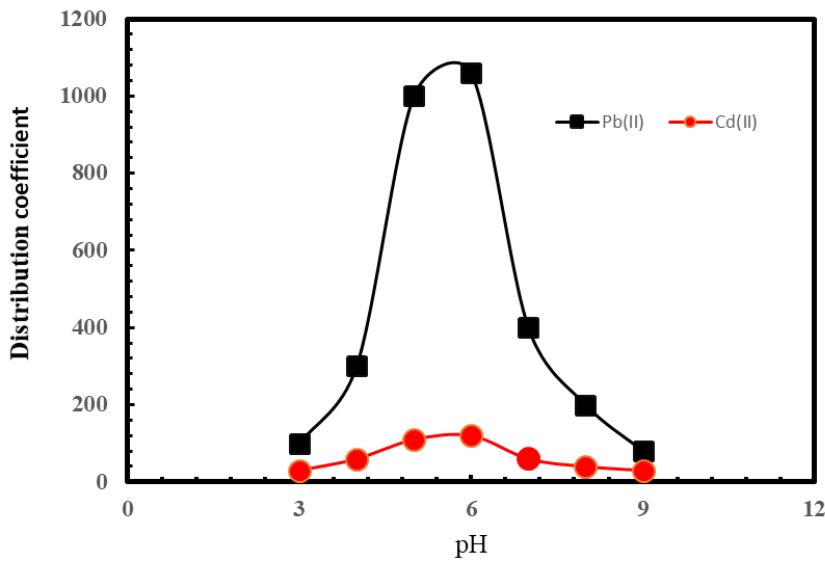
Figure 8. Distribution coefficient for Pb 2+ and Cd 2+ adsorbed onto BI@MWCNTs at different pH. Table 2. Adsorption presentation of BI@MWCNTs applied for the removal of Pb 2+ and Cd 2+ at a pH 5 and 100 mg/L metal start concentration.